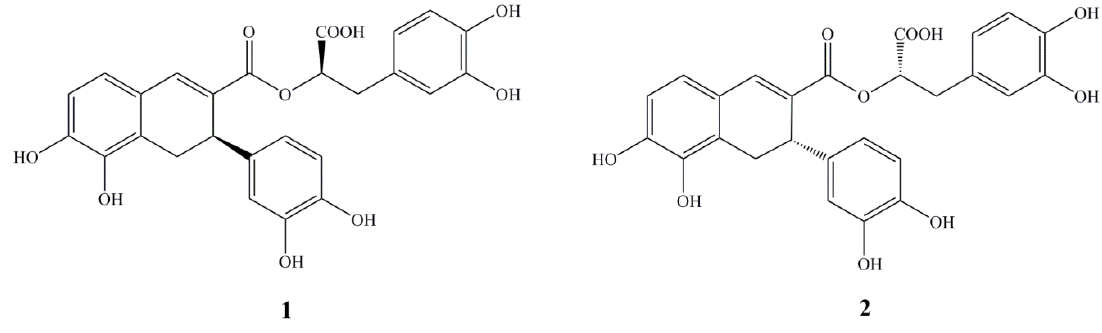
Figure 1. Structures of the stereoisomers isolated from Danshen Injection (lyophilized